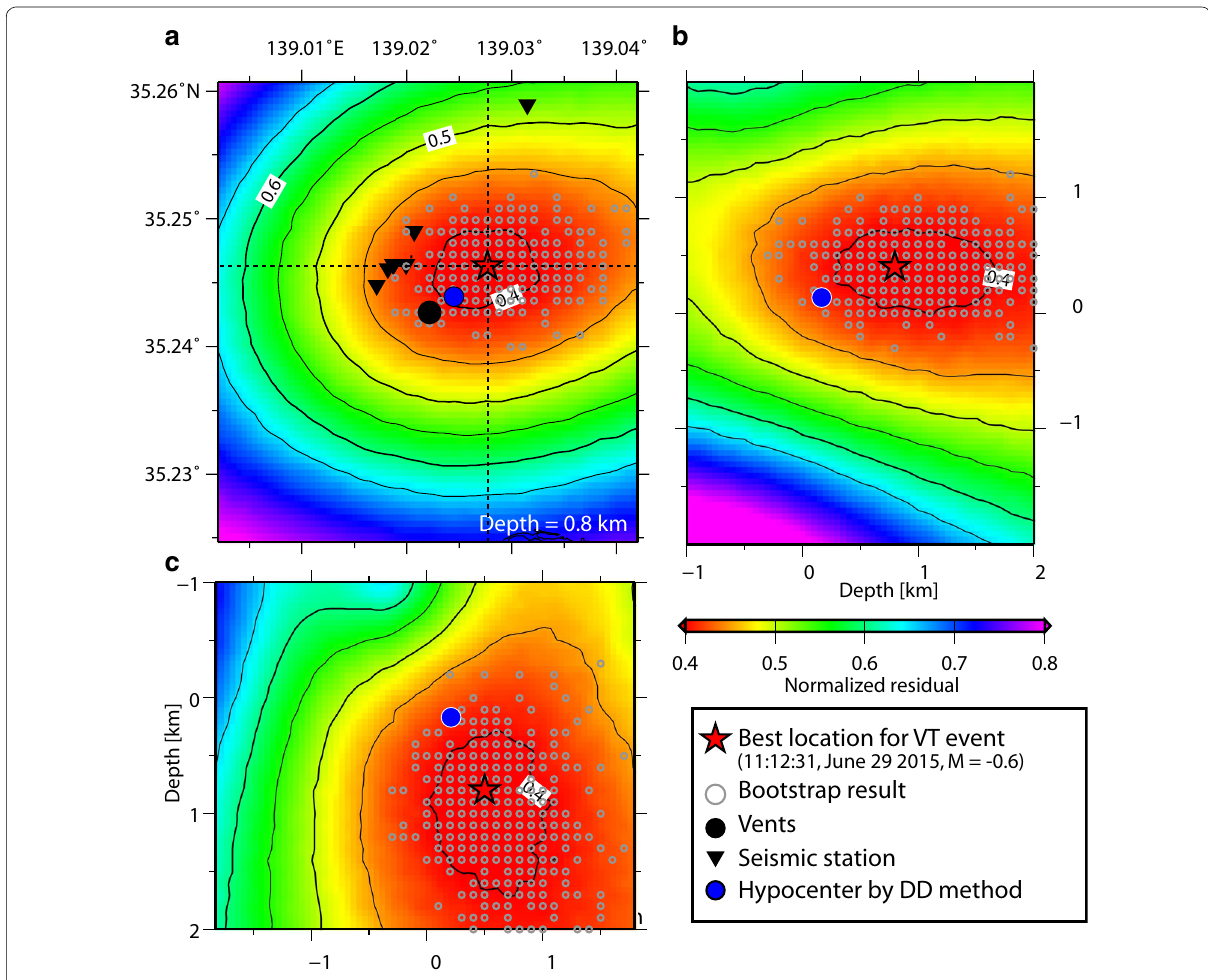
Fig. 8 Result of a grid search for hypocenter of a VT earthquake. a Epicenter, b N–S cross section, and c E–W cross section. The red star and gray circles indicate the best solution for the hypocenter and the results of the bootstrap resampling method, respectively. The blue circle indicates the hypocenter of the VT earthquake as determined using the double difference